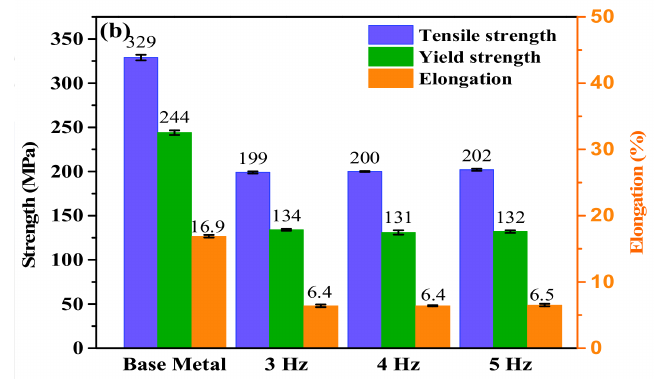
Figure 10. Tensile properties of the base metal and welded joint. ( a ) Tensile curves; and, ( b ) Result of tensile tests.